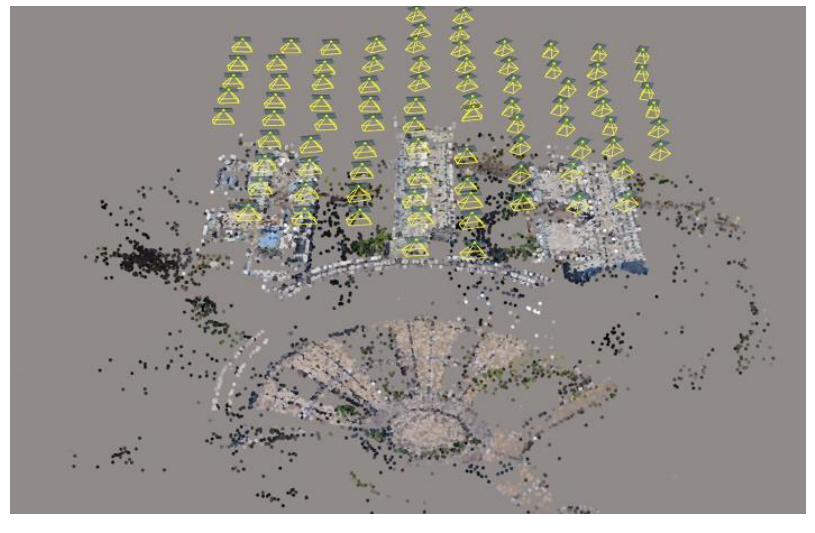
Figure 11. Key points and photography sites.